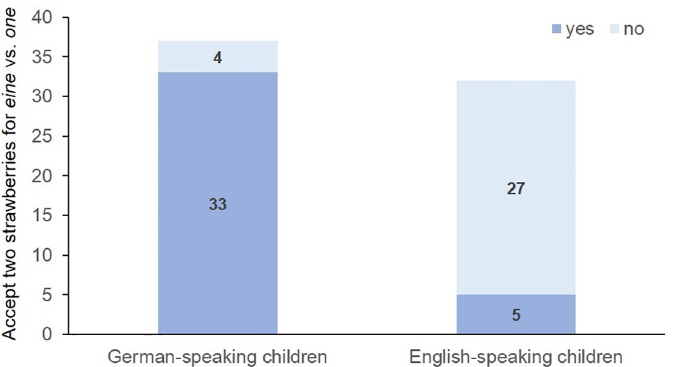
Figure 2. Number of German-speaking children and English-speaking children regarding their acceptance and rejection rates for two strawberries as a response to eine (German) and one (English) during the critical trial. The data of the English- speaking sample was retrieved from Barner and colleagues